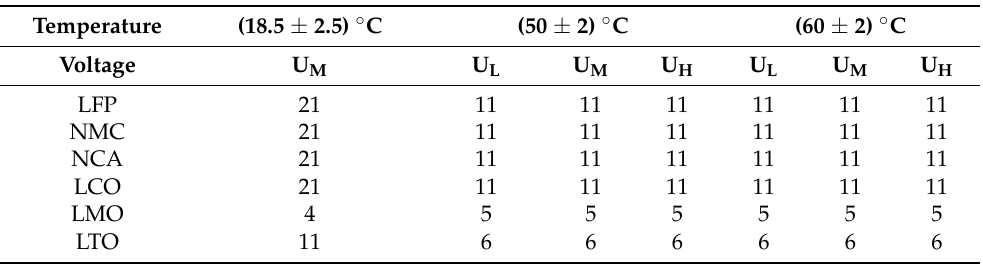
Table 2. Number of cells at different storage temperature and voltage conditions, with the rightmost column being stored in a safety cabinet in the